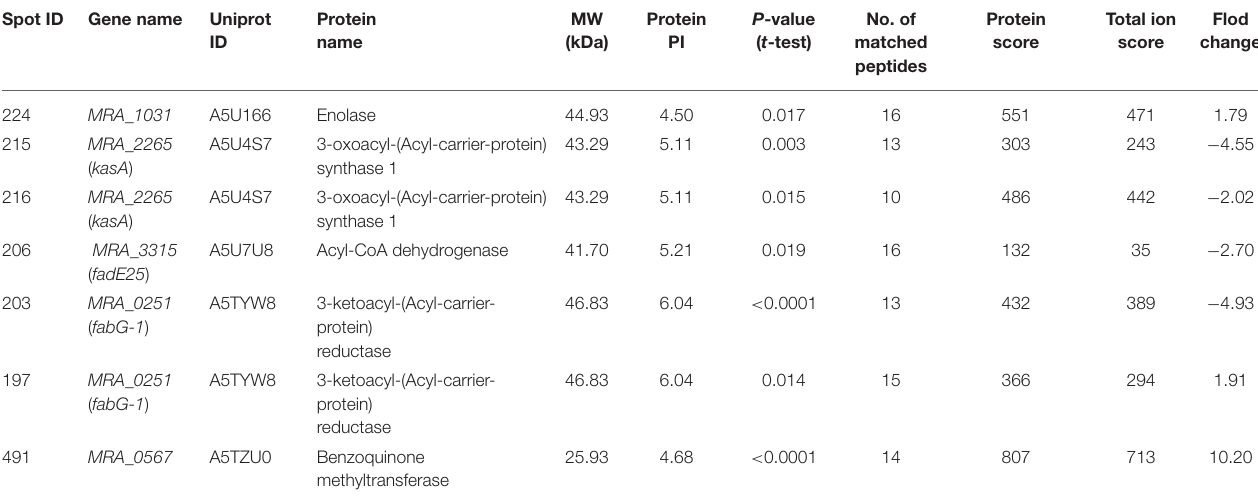
TABLE 3 | List of significant differentially expressed proteins identified in TPSA-treated H37Ra using 2-D electrophoresis and MALDI/TOF-TOF. Spot ID Gene name